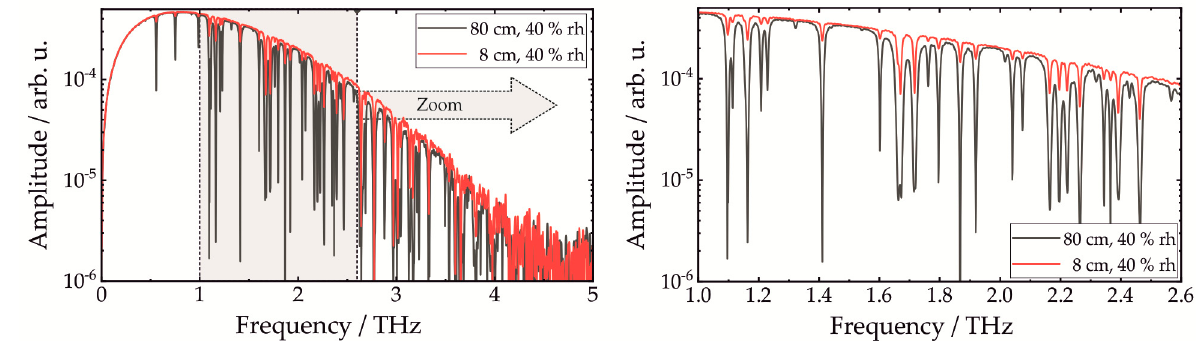
Figure 7. Simulation of the effect of water vapor in the terahertz beam path of 80 cm in comparison to 8 cm using the HITRAN database [28]. By purging 90% of the terahertz beam path in the system, the spectral quality can be significantly enhanced.